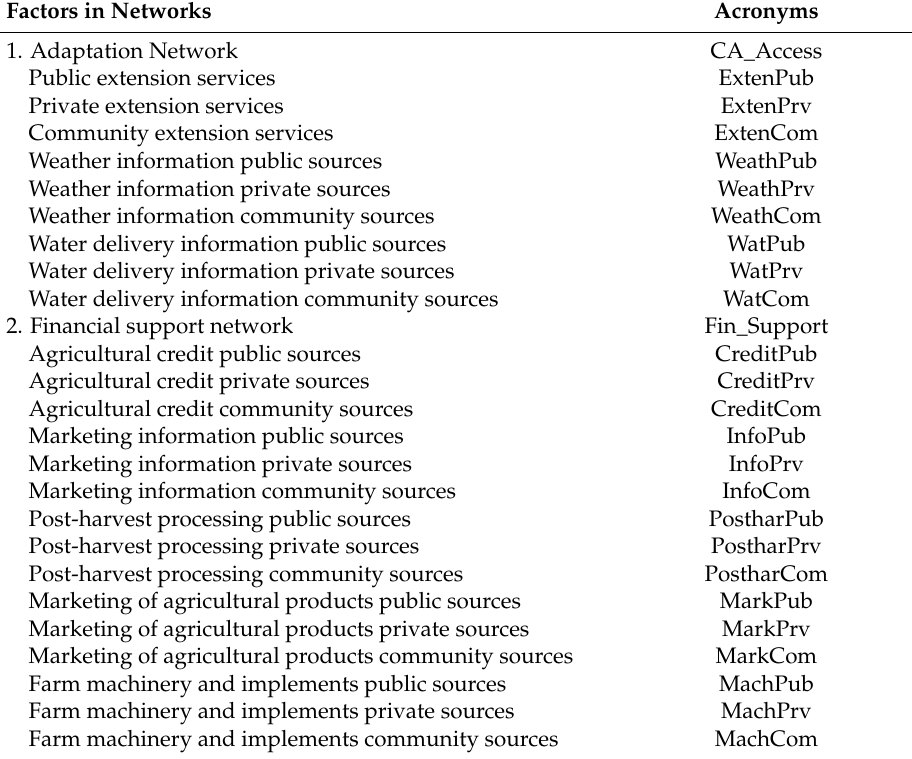
Table A1. Acronyms representing nodes in adaptation and financial support